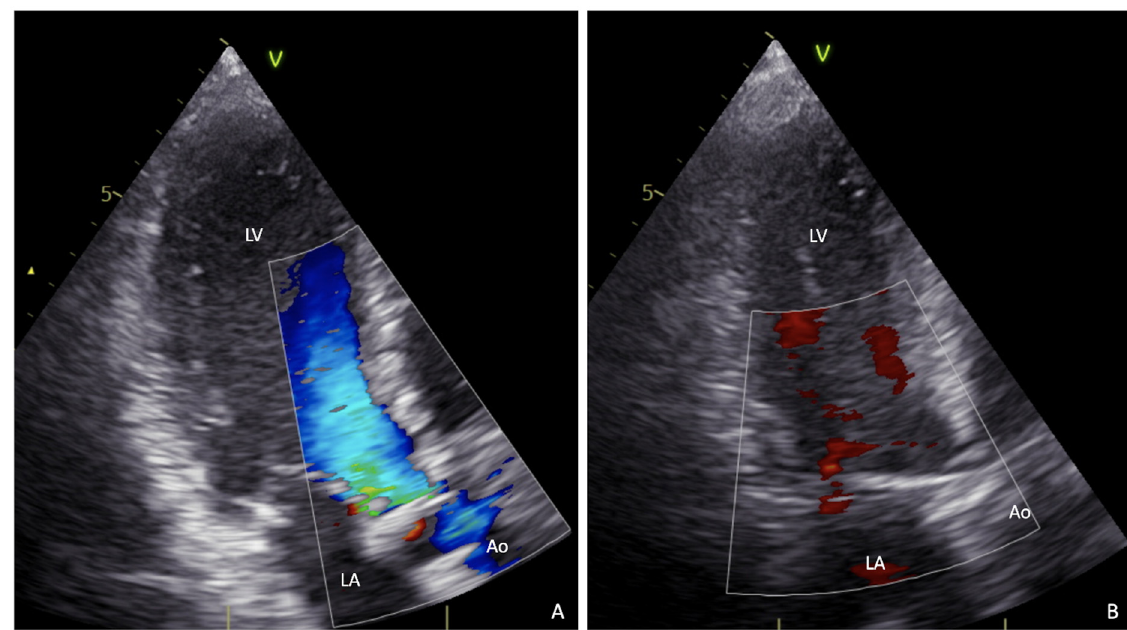
Figure 3. Post-operative transthoracic echocardiography (TTE). Long-axis three-chambers view in late diastole ( A ) and systole ( B ) at color doppler TTE showing no paravalvular leak (PVL) of the AVR and good result of the mitral valve